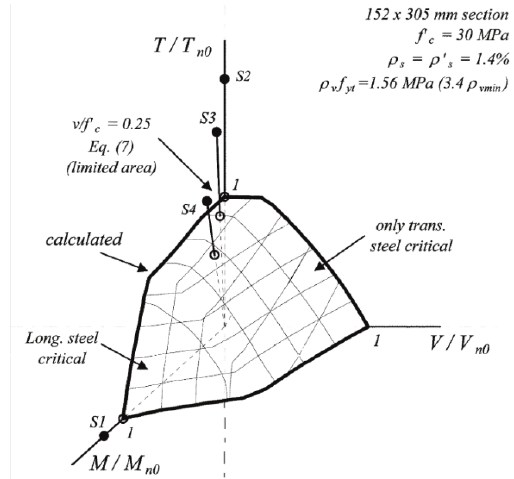
Figure 21: Adapted from Rahal’s AASHTO surface for beams S1-S4 [19].M5 to M7 beams.